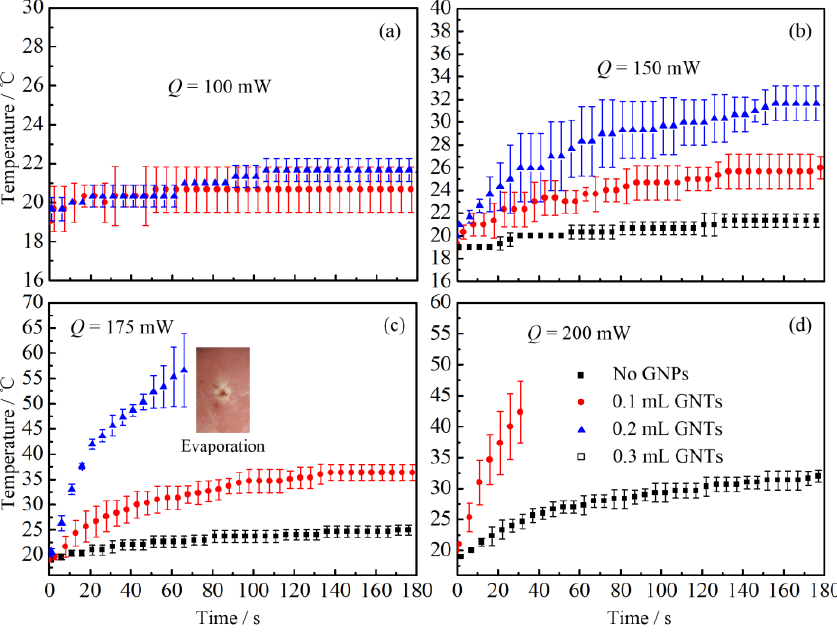
Figure 6. Temperature changes of biological tissue after injecting different amount of GNT solution: